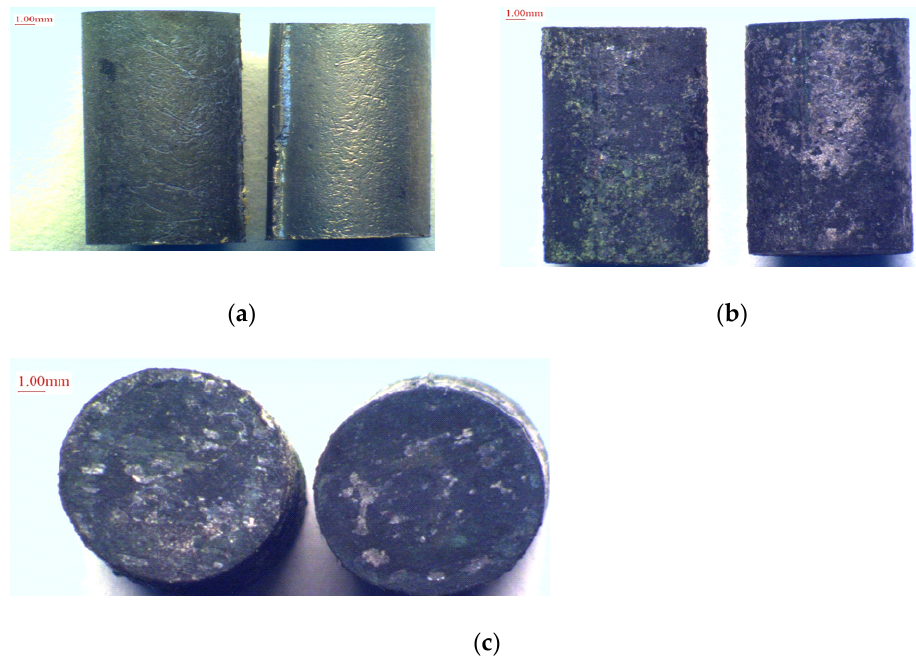
Figure 2. The appearance of samples before ( a ) and after corrosion tests ( b , c ) from the CM88Y alloy (left) and the experimental alloy (right).